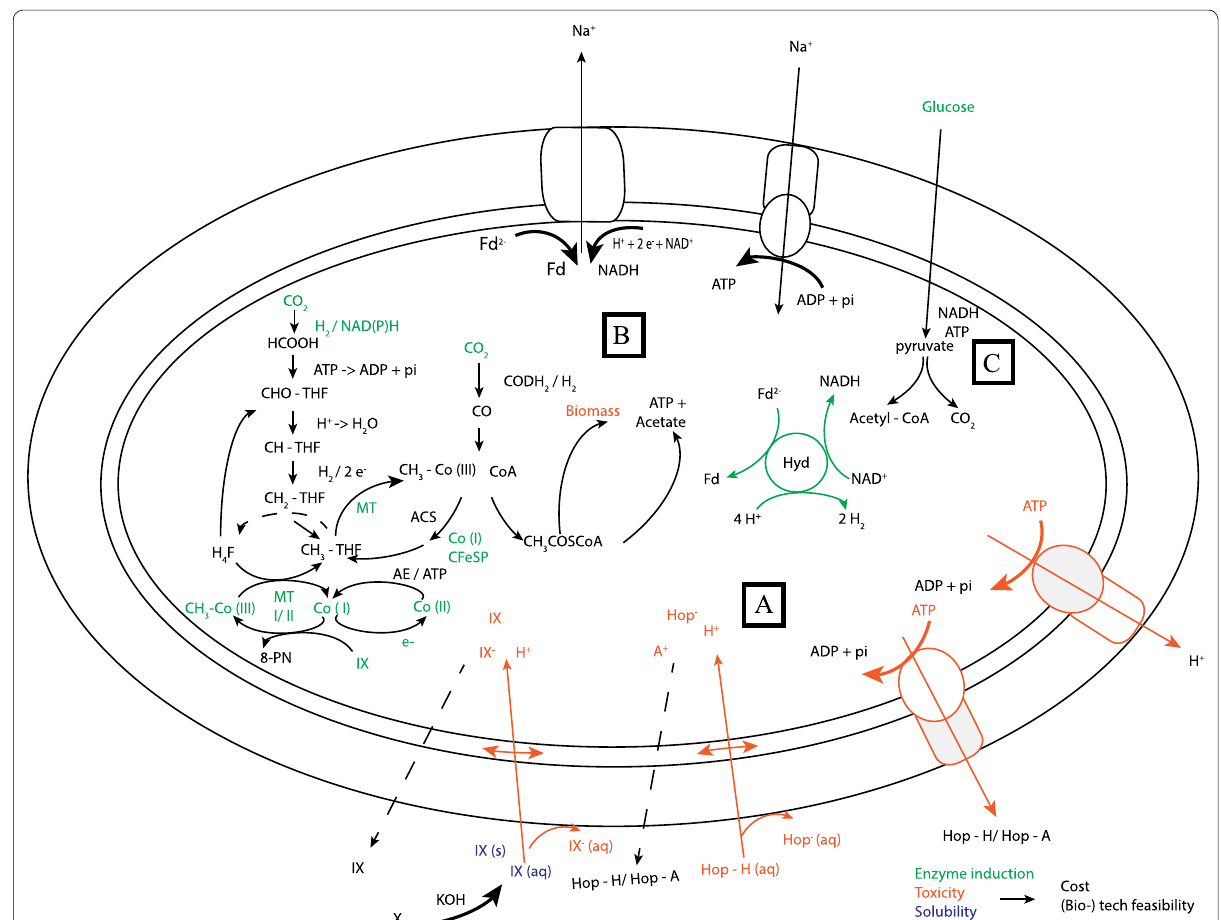
Fig. 1 Schematic representation of presumed factors influencing the conversion of abundant hop metabolite xanthohumol (X) to 8-prenylnaringenin (8-PN). The process starts with conversion of X from spent hops into isoxanthohumol (IX) by chemical isomerization with KOH, followed by enzymatic demethylation of IX into 8-PN by Eubacterium limosum . Cellular transport of hop compounds may occur via diffusion or via specific transporters (A). Conversion of IX to 8-PN is suggested to occur via the Wood-Ljungdahl pathway in absence (B) or presence (C) of carbohydrates such as glucose. The major enzymes involved in O -demethylation of IX are methyltransferase I (MT I), corrinoid protein (CFeSP) with cobalt in the respective oxidation states Co (x), methyltransferase II (MT II), activating enzyme (AE), Coenzyme A (CoA), carbon monoxide dehydrogenase (CODH), acetyl-CoA synthase (ACS). Small adaptations were made from the schemes provided by Drake (1994), Sakamoto (2003), Studenik (2012), Jeong (2015). The green, red and blue parts in the figure may be important factors in the study of solubility of IX, toxicity of